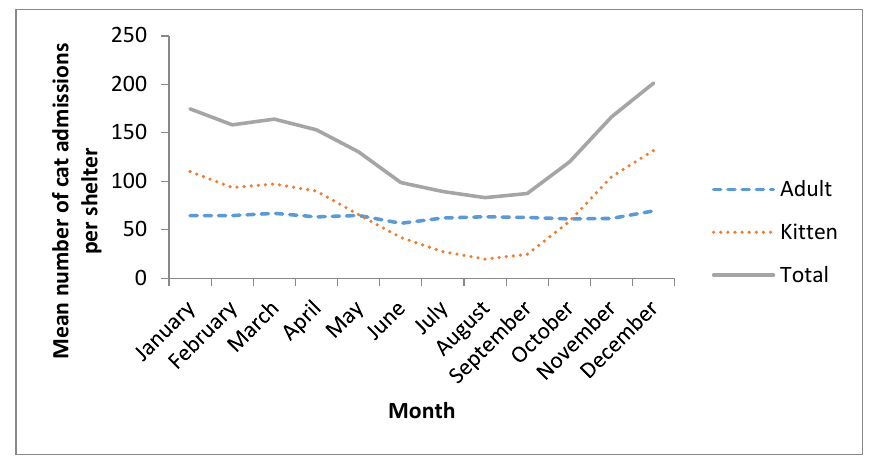
Figure 1. Mean numbers of cat admissions per RSPCA shelter per month between June 2006 and July 2010 by age category and calendar month of admission. Table 7. Ratios of geometric mean numbers of cat admissions per shelter to 39 RSPCA shelters between June 2006 and July 2010 by calendar month in comparison to December (reference group).